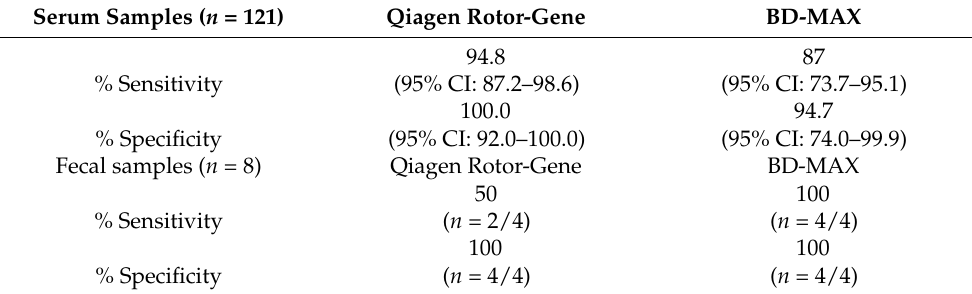
Table 2. Sensitivity and specificity of RT-PCR assay using serum and fecal samples. Confidence intervals were not calculated on groups with <10